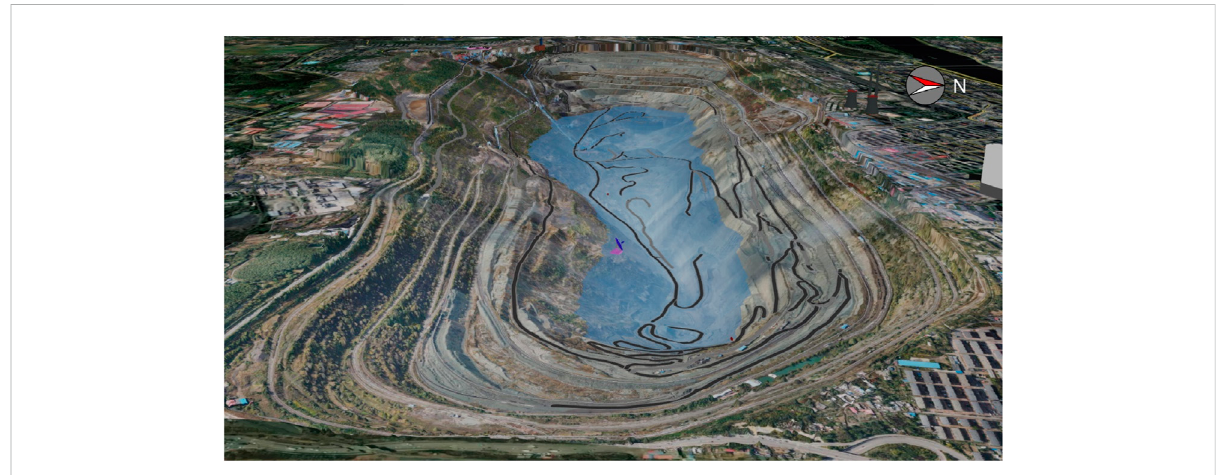
FIGURE 7 Inundation analysis using the 3D surface obtained by tilt photogrammetry. The gray line represents the transportation road, and the light blue represents water.